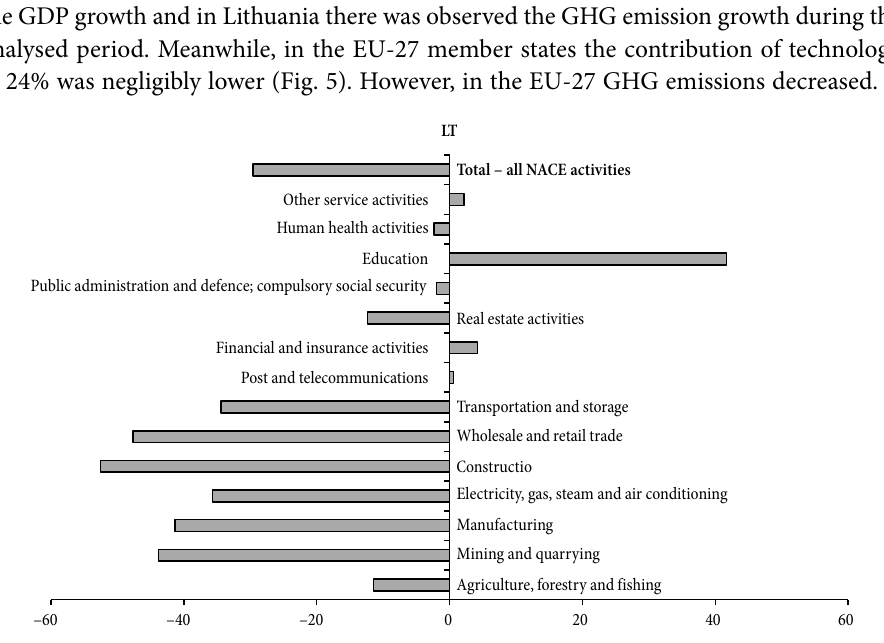
Fig. 4. Technological contribution expressed as percentage during 2000–2012 in Lithuania